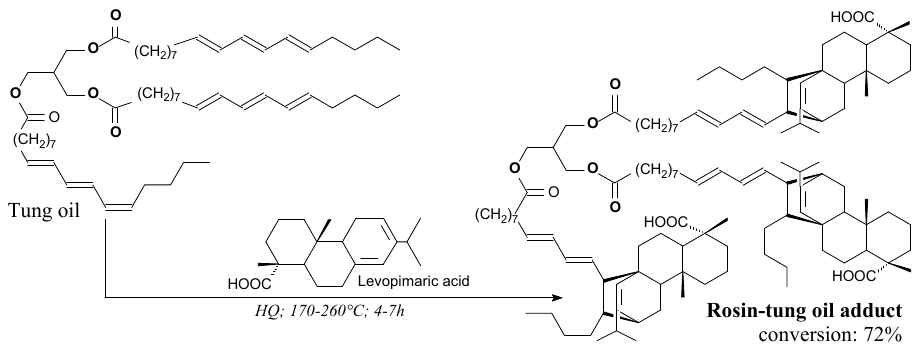
Scheme 82. Preparation of idealized rosin-tung oil Diels-Alder adduct.